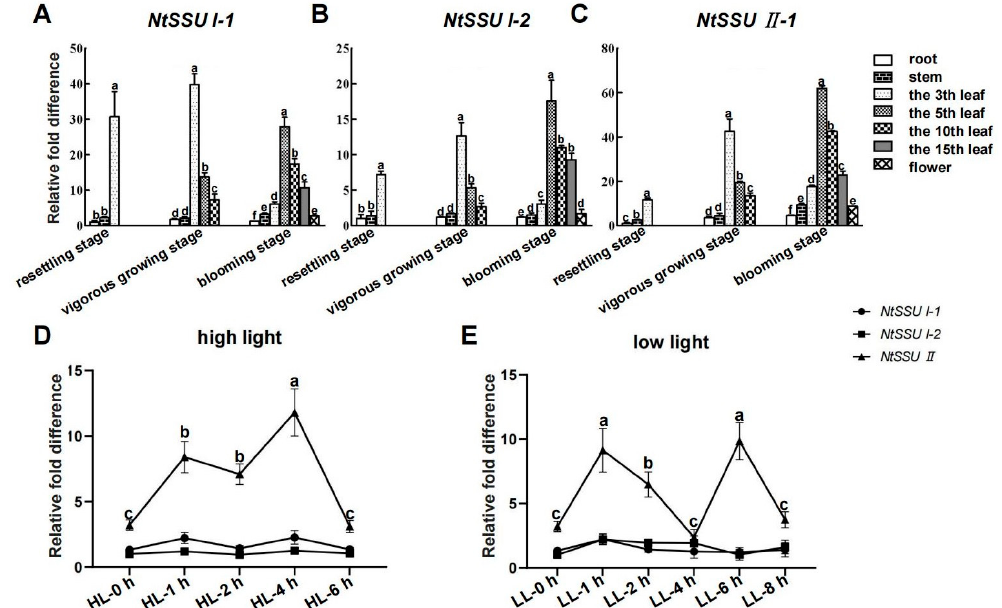
Figure 2. The expression profiles of NtSSU II , NtSSU I-1 , and NtSSU I-2 in various growth stages and in response to light treatments. ( A – C ) Different tissues including root stem, the 3rd leaf, the 5th leaf, the 10th leaf, the 15th leaf, and flower were harvested at resettling stage, vigorous growing stage, and blooming stage, respectively. ( D ) Four weeks-tobacco plants were selected for high light (1000 μ mol m − 2 s − 1 ) treatment. The leaves were collected after 1 h high light treatment (HL-1 h), HL-2 h, HL-4 h, and HL-6h, respectively, using no treatment tobacco as control (HL-0 h). ( E ) Four weeks-tobacco plants were selected for low light (100 μ mol m − 2 s − 1 ) treatment. The leaves were collected after 1 h low light treatment (LL-1 h), LL-2 h, LL-4 h, LL-6h, and LL-8h, respectively, using no treatment tobacco as control (LL-0 h). Relative expression was evaluated by qPCR using 26s rRNA as a reference gene. Three biological replicates were applied for each experiment. Data are presented as means ± SEM (n = 3 biological replicates). Different letters represent significant differences at p < 0.05; one-way ANOVA.